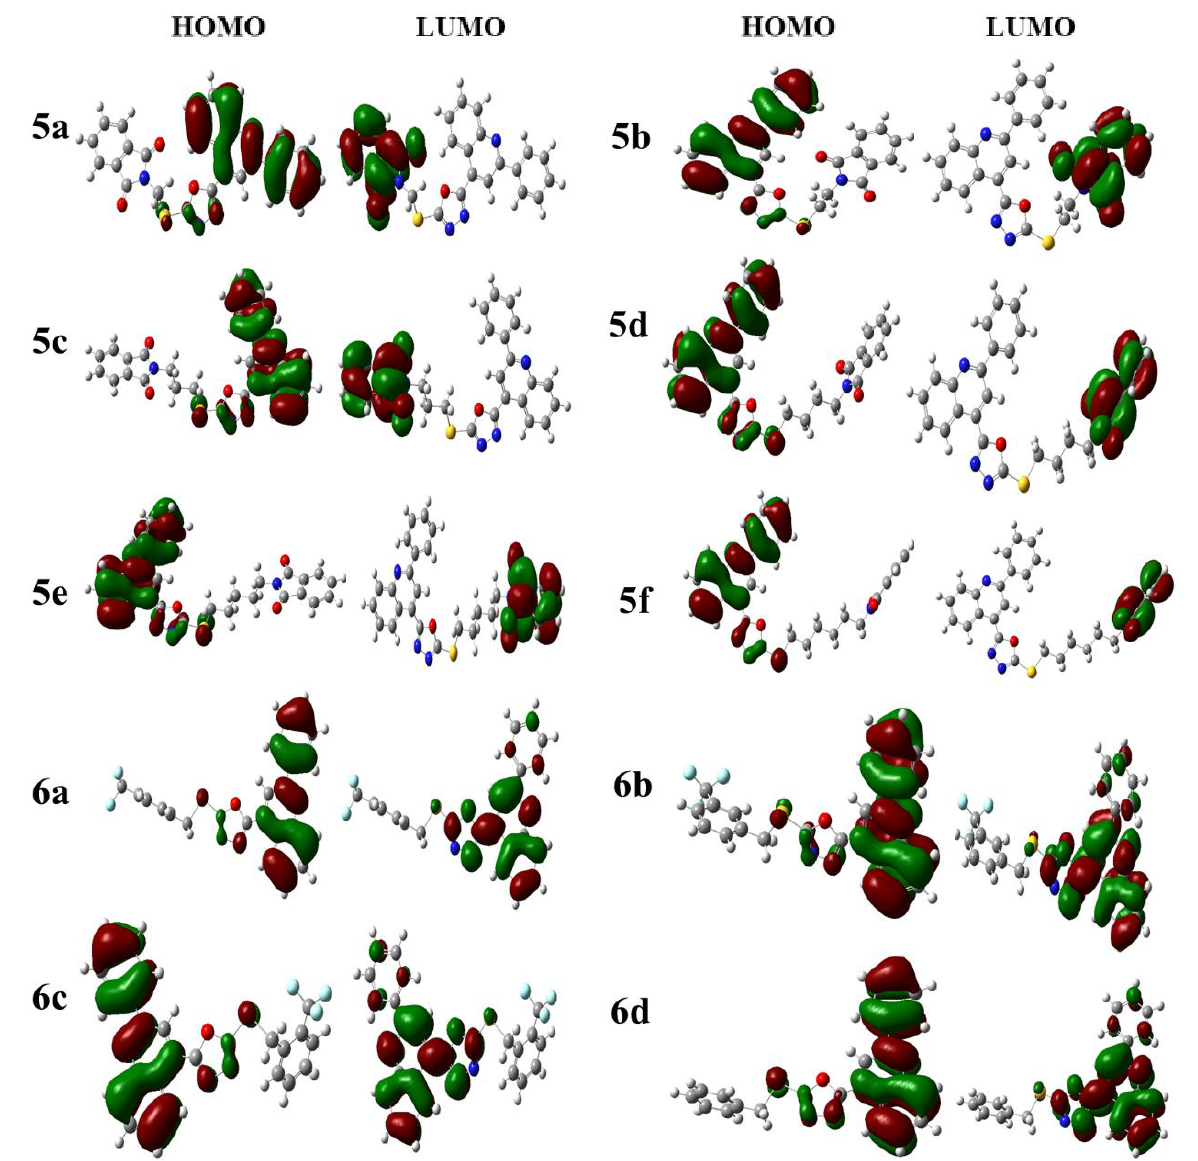
Figure 7. Diagrams of HOMO and LUMO distributions of compounds 5a – f and 6a – d.